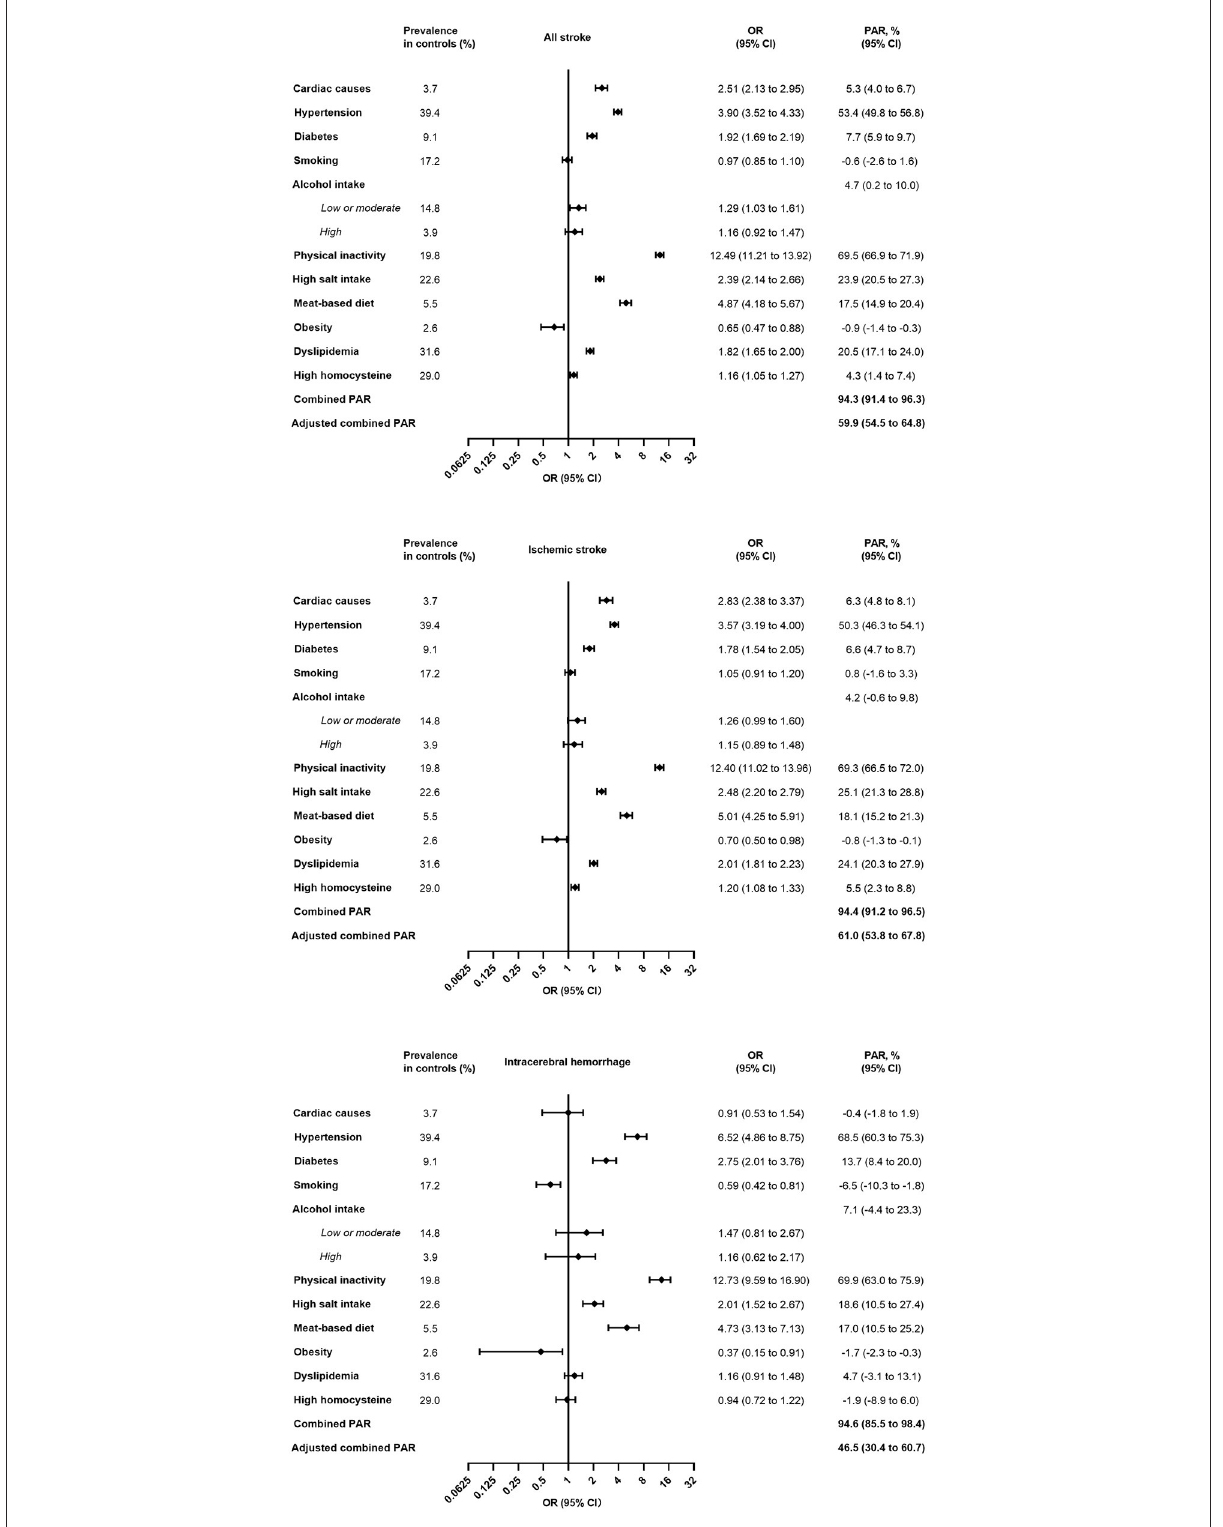
FIGURE1 Multivariable analysis of prevalence of risk factors, OR, and PAR for eleven risk factors. OR, odds ratio; PAR, population attributable risk. For alcohol intake, PAR was calculated using low or moderate + high vs. never.